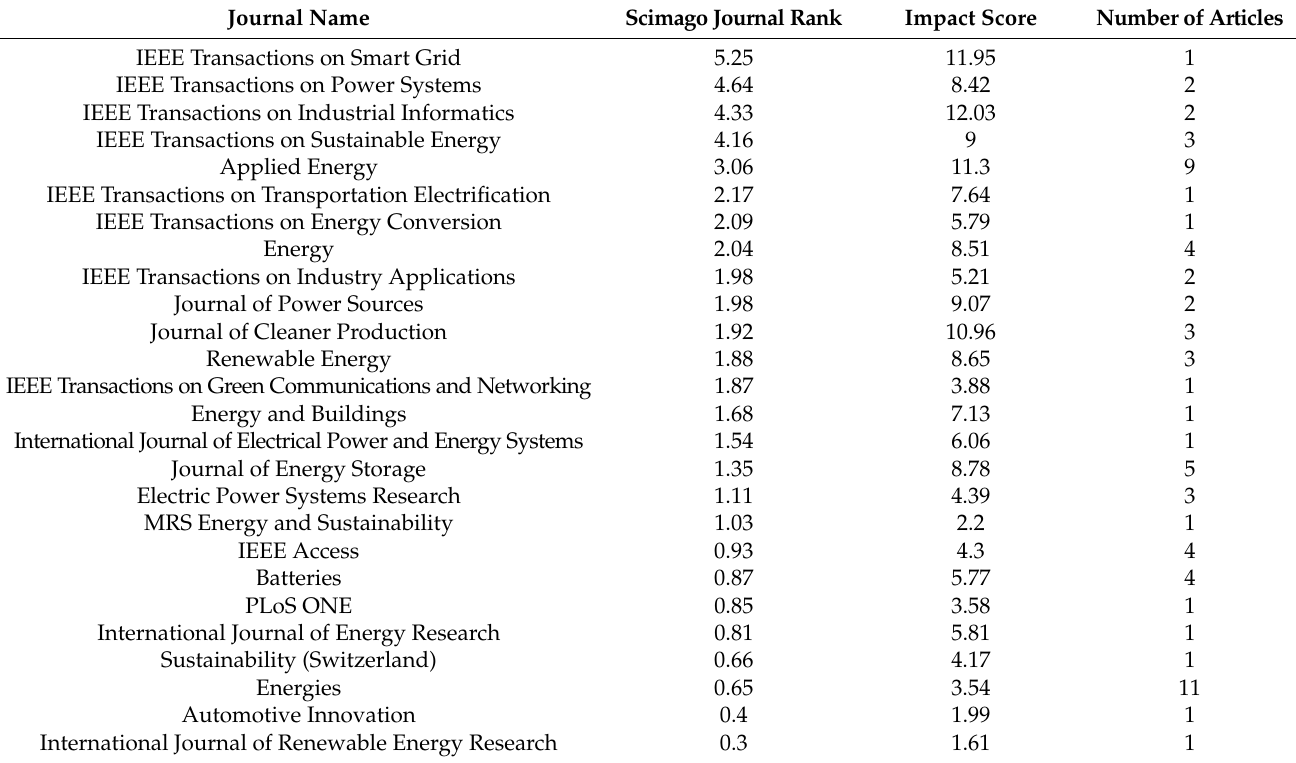
Figure 2. Number of BESS-related publications eligible for review in the last five years. Meanwhile, 69 comprehensive articles have been selected for review. The acquired data has a Q1 journaling tool from the Scimago Journal Rank (SJR). Table 3 shows the list of publications or journals selected for review. Table 3. Distribution of articles in each journal.